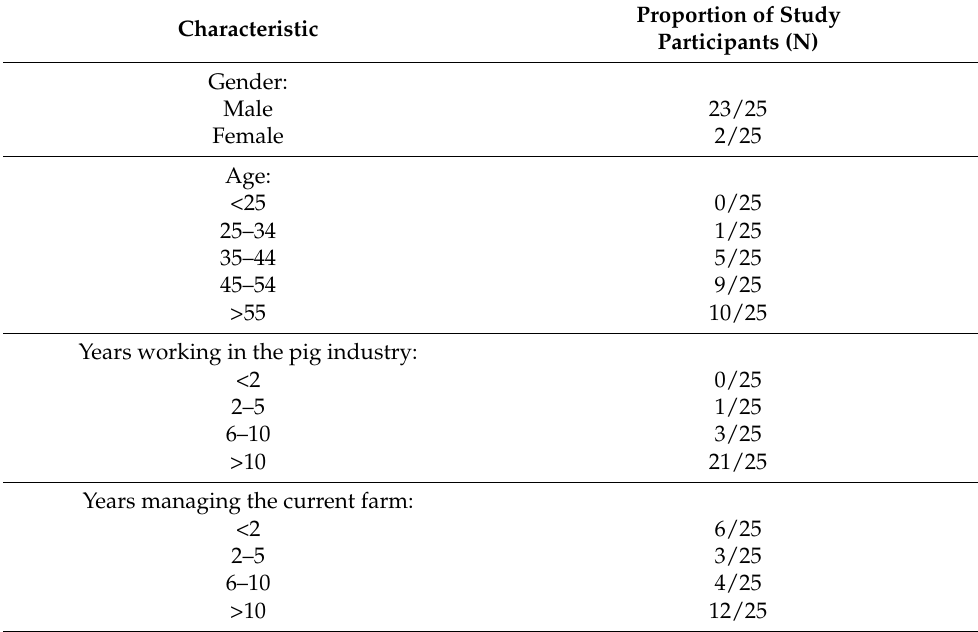
Table A1. Demographics of the 25 pig farm managers who participated in the study.